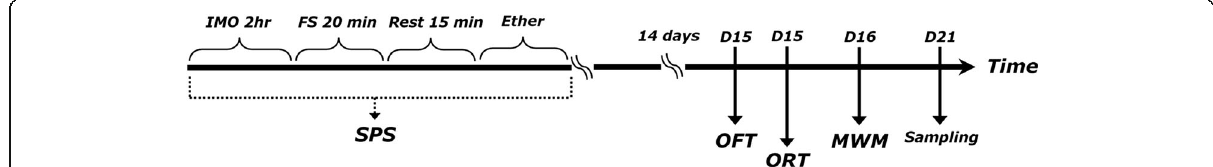
Fig. 2 Experimental protocol of single-prolonged stress (SPS)-induced memory impairment and subsequent treatment with A. continentalis (AC)(B). Groups of seven rats were used for each experimental condition. OFT; open field test, ORT; object recognition task, MWM; Morris